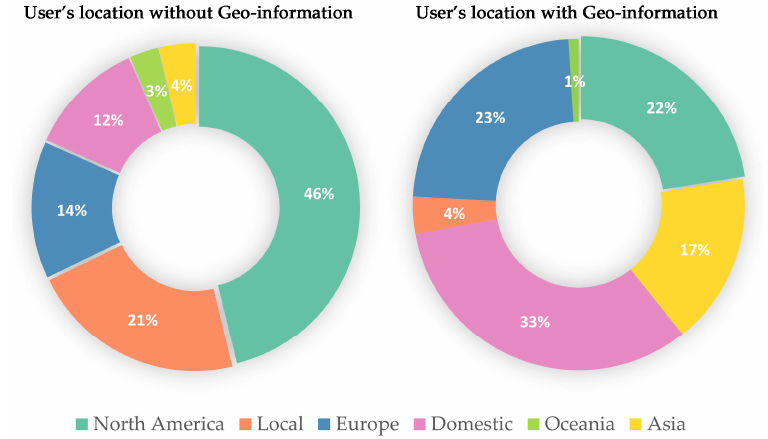
Figure 5. Group statistics by user’s location.